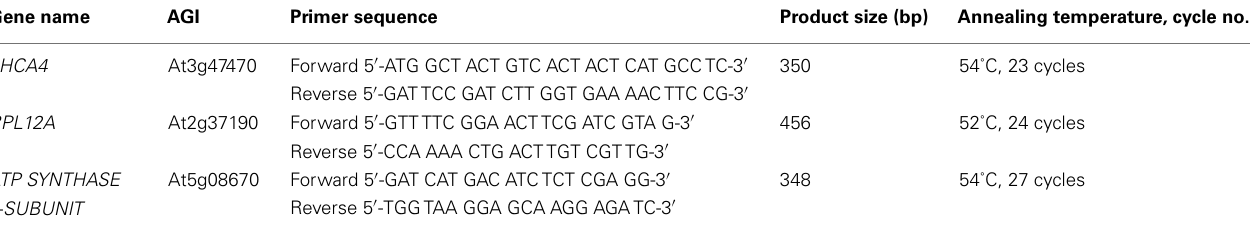
Table 1 | Oligonucleotide primers and RT-PCR